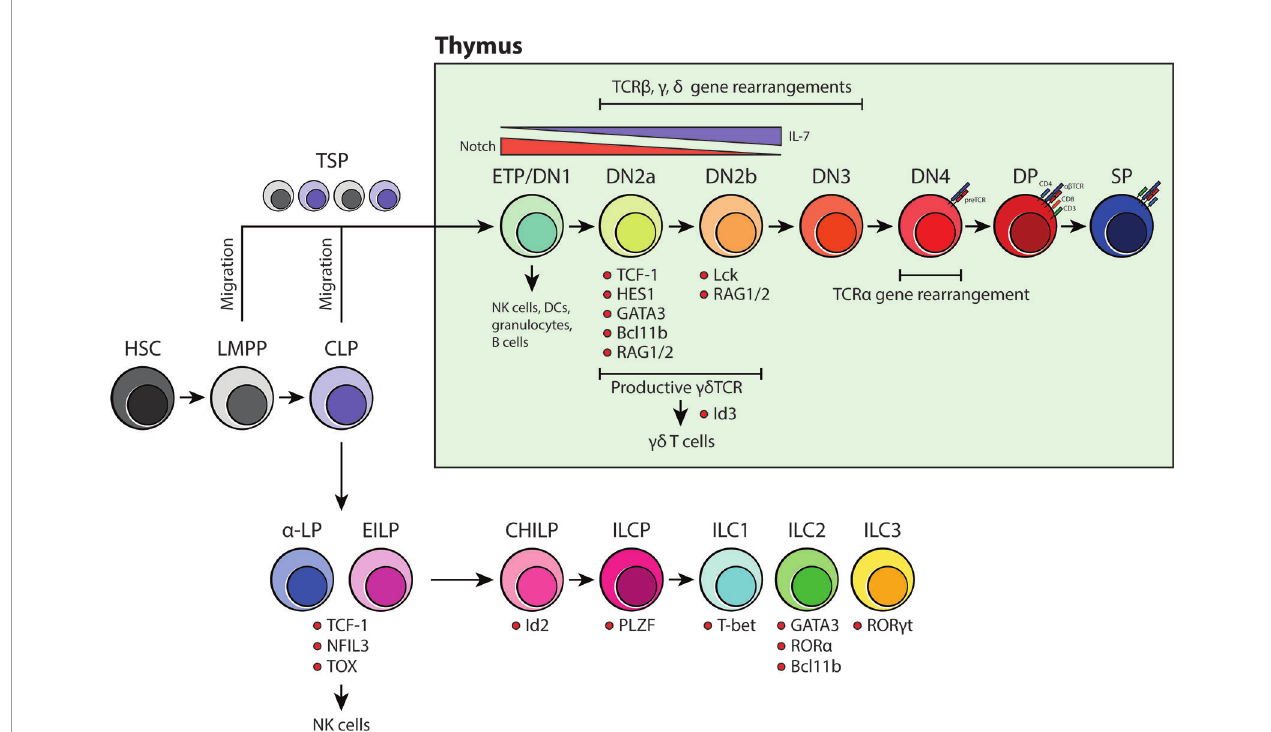
FIGURE 1 | An overview of BM-dependent ILC and thymus-dependent T-cell development. Current models for both ILC and T-cell development suggest that they are of distinct lineages and that the site for maturation do not overlap beyond the CLP stage. ILCs have been proposed to develop in the BM whereas committed T-cell progenitors undergo intense development processes that are heavily in fl uenced by the thymic